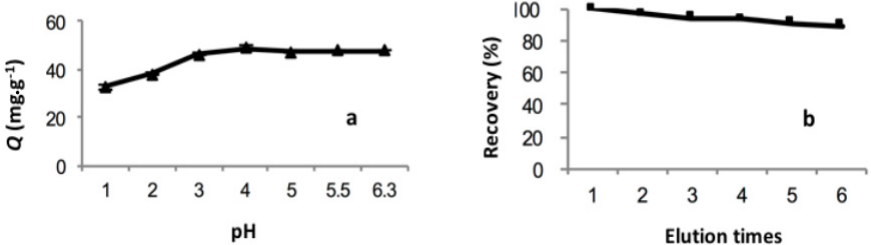
Figure 11. Effect of pH ( a ) and elution times; ( b ) on the adsorption capacity of MIIP.